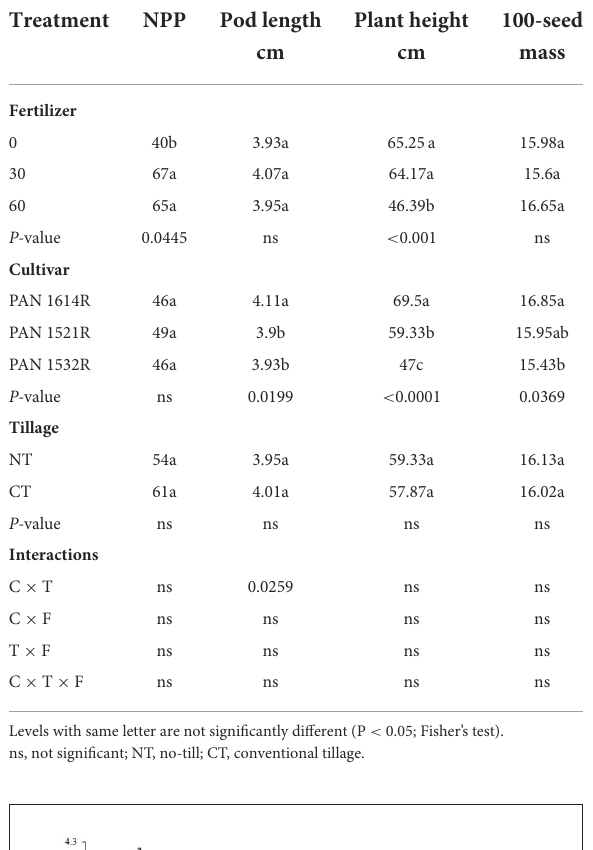
TABLE 7 Effects of fertilizer, cultivar and tillage on number of pods per plant (NPP), pod length, plant height, and 100- seed mass on a soybean cropping system.